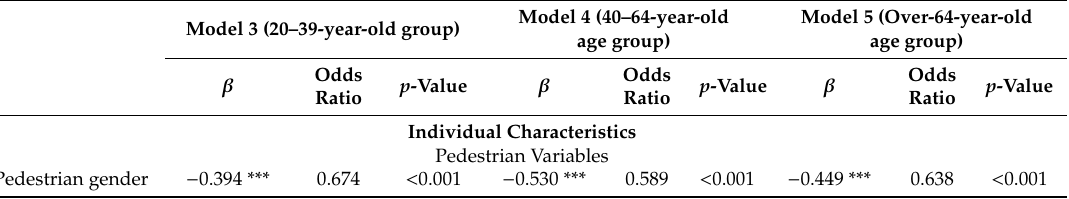
Table 3. The results of binary logistic